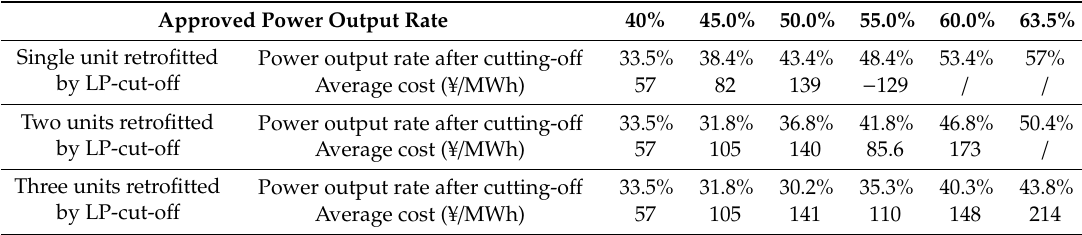
Table 1. Comparison of the average cost for DDR (¥ / MWh).